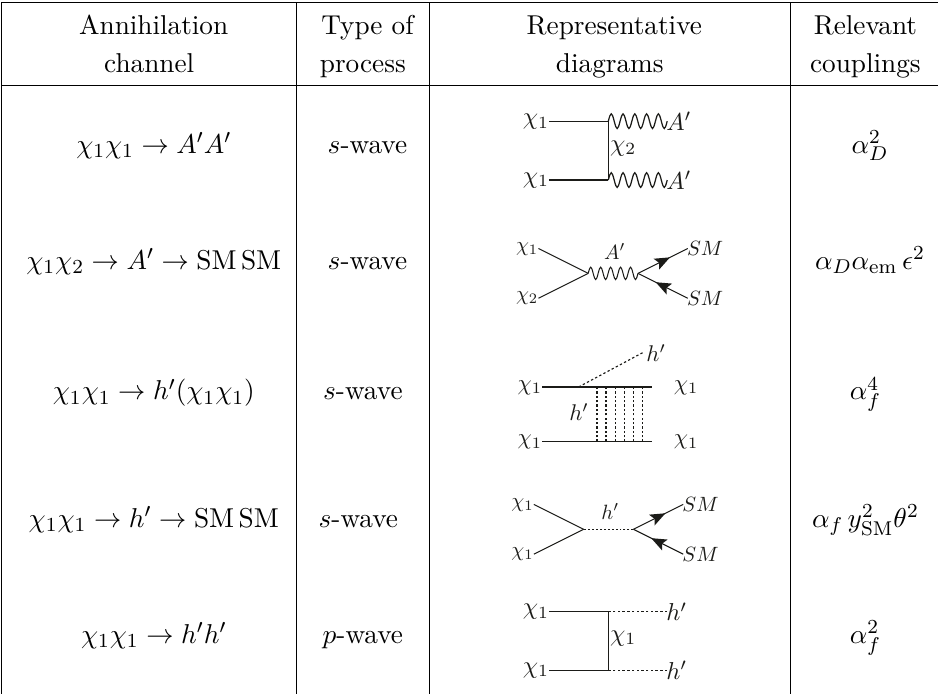
Table 1 . (Co-)annihilation channels involving DM. Here ( χ 1 χ 1 ) and SM respectively stand for DM bound state and Standard Model particle. α corresponding SM Yukawa